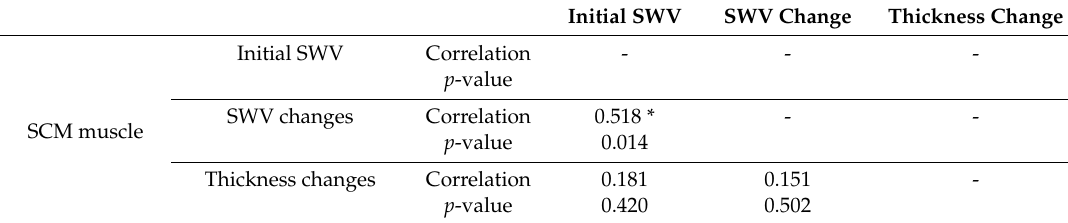
Table 5. Correlations among initial shear-wave velocity of the sternocleidomastoid muscle and changes in shear-wave velocity, sternocleidomastoid muscle thickness, and cervical range of